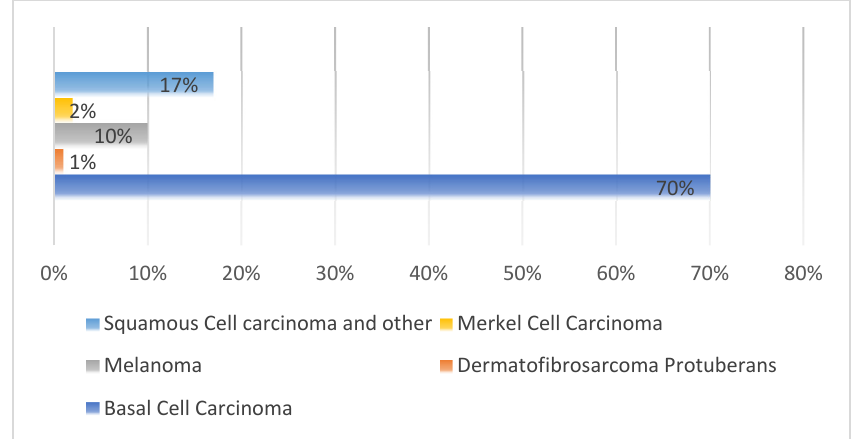
Figure 1. According to Reference [4], a number of different types of skin cancer are widespread.